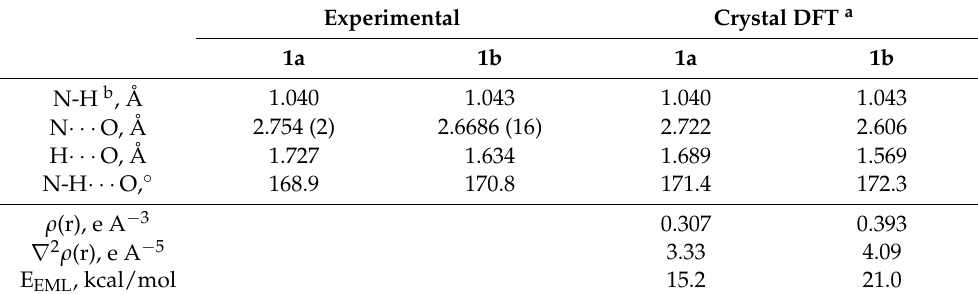
Figure 3. Supramolecular synthons in crystals 1a ( left ) and 1b ( right ). Table 3. Geometrical parameters and characteristics of ρ (r) in BCPs for intermolecular H-bonds in polymorphs 1a and 1b